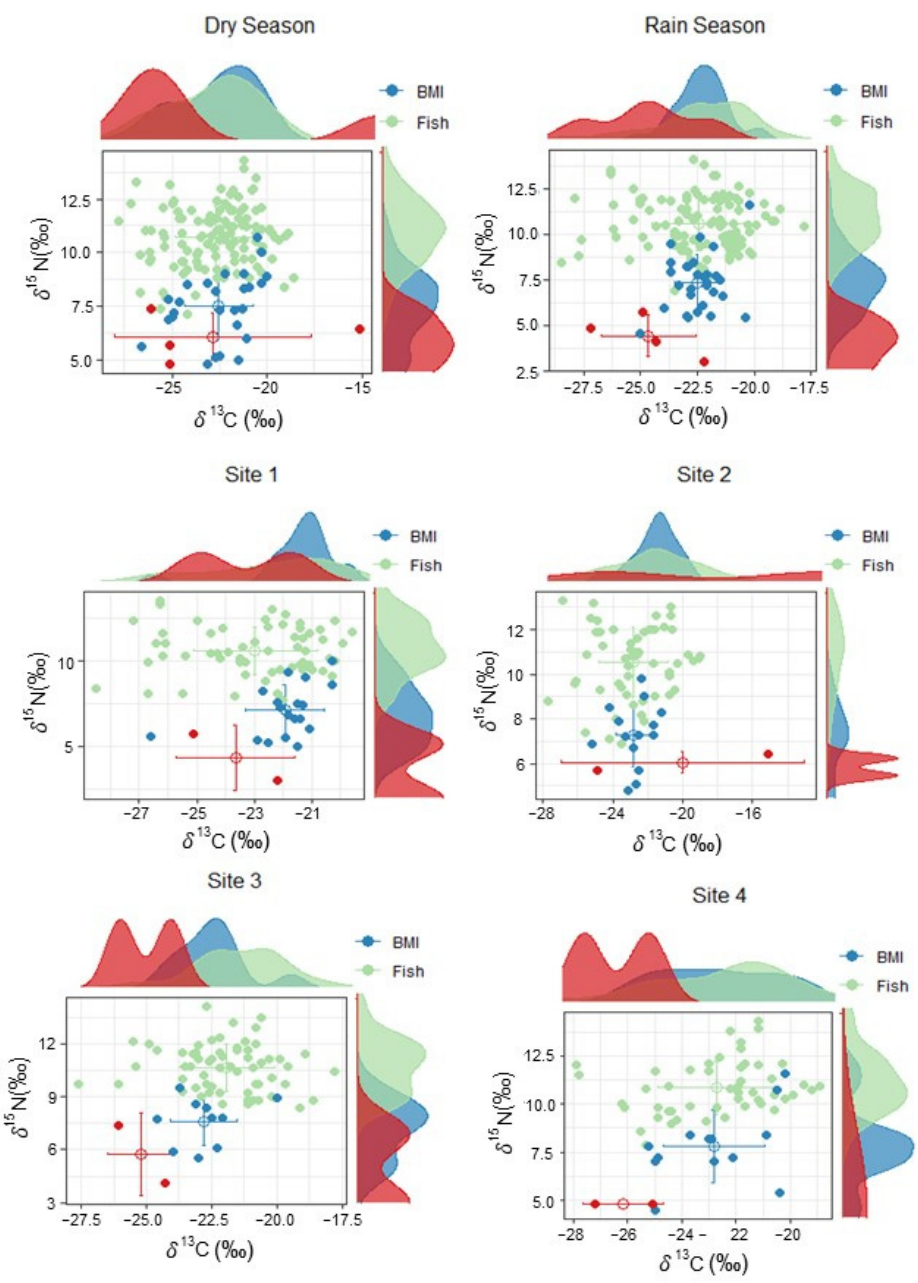
Figure 6. Bayesian model for the calculation of consumer (fish species: green color) trophic position using stable isotopes of C and N with BMI (macroinvertebrates: blue color) and Zooplankton (red color) as baseline for the different sites and seasons in Lake Zacapu.